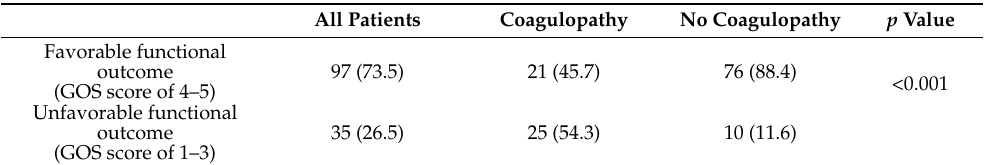
develop coagulopathy after open TBI.